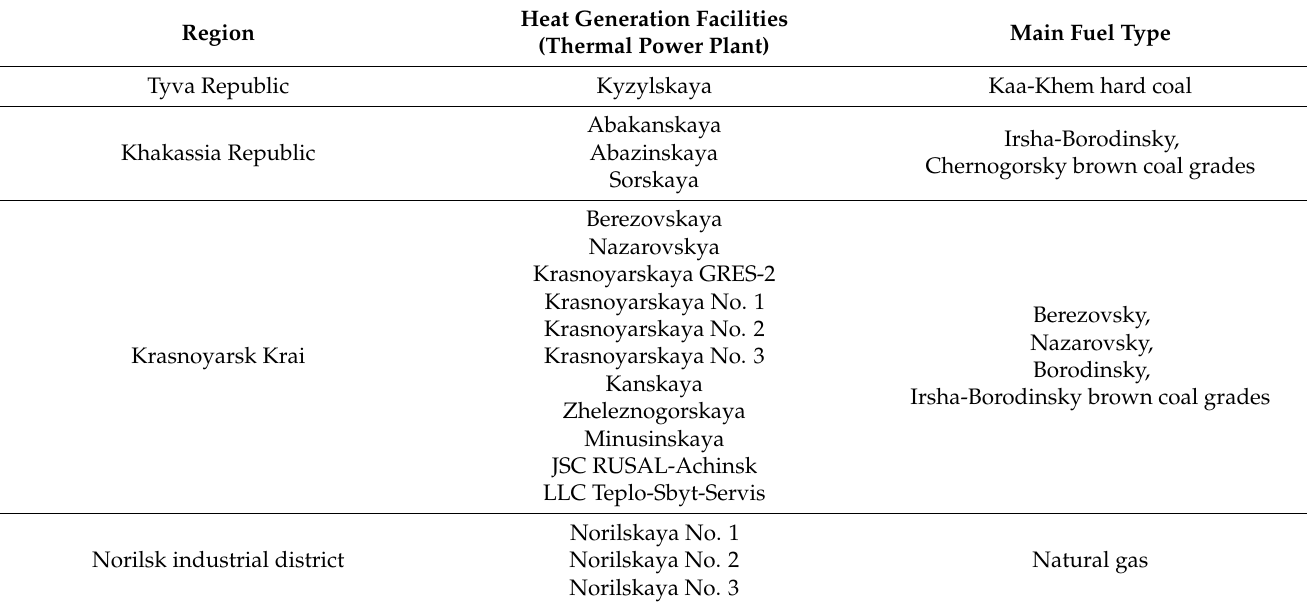
Table 2. Heat generation facilities in Yenisei, Siberia. Source: Heat Supply Schemes for Cities in Yenisei, Siberia. Note: GRES—State District Power Plant (Thermal Power Plant). Region